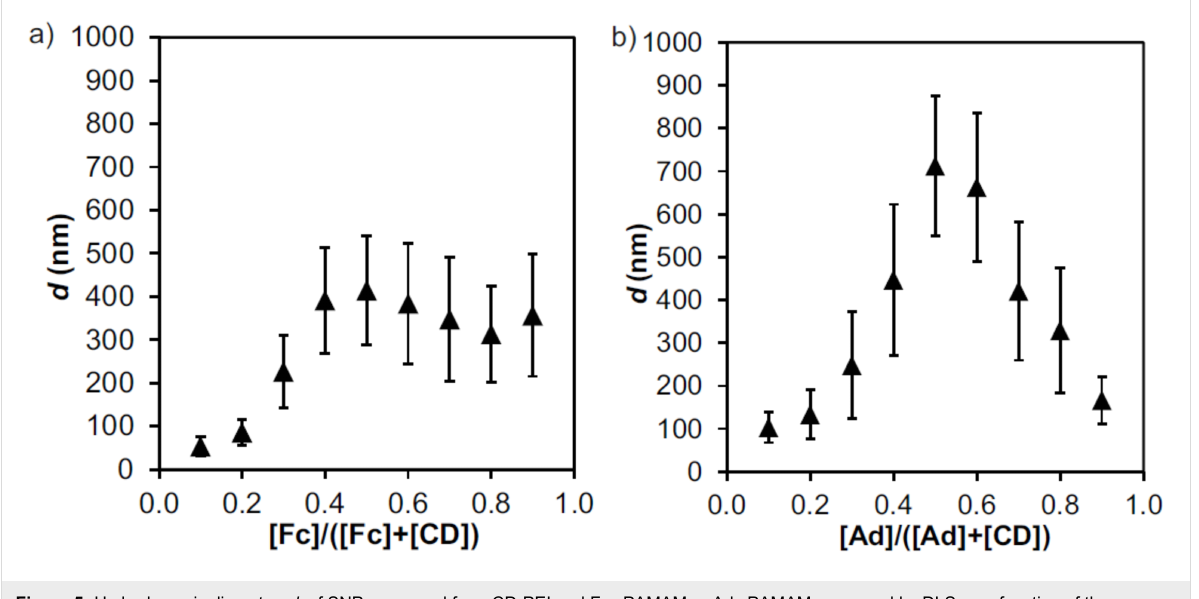
Figure 5: Hydrodynamic diameter, d , of SNPs prepared from CD-PEI and Fc 8 -PAMAM or Ad 8 -PAMAM measured by DLS as a function of the [guest]/([guest] + [CD]) ratio for: a) CD-PEI and Fc 8 -PAMAM [CD + Fc] = 50 µM (in CD and Fc moieties), I = 0.4 M NaCl, with 2 mM native CD measured after 10 min, and b) CD-PEI and Ad 8 -PAMAM [CD + Ad] = 200 µM (in CD and Ad moieties), I = 0.2 M NaCl, with 2.0 mM native CD measured after 6 min.